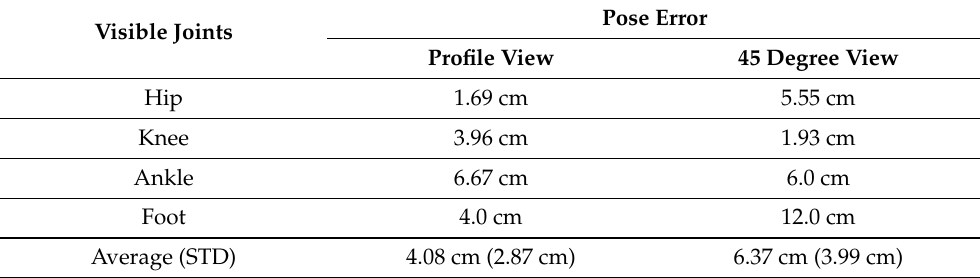
Figure 3. Errors in millimeters for the visible joints (hip, knee, ankle, foot) around the knee recorded from the profile view (upper row) and from 45° degree. The start and end body configurations are shown in the left image of the upper row. The extreme position of the exercise can be seen in the left side of the lower row. Exercise is executed twice. Error averages and standard deviations are in Tables 4 and 5. Average error is only a few centimeters, typically 5 cm or smaller, except for the foot for 45°. Table 4. MeTRAbs 3D Body Pose error results. STD: standard deviation. Distance: 2.3